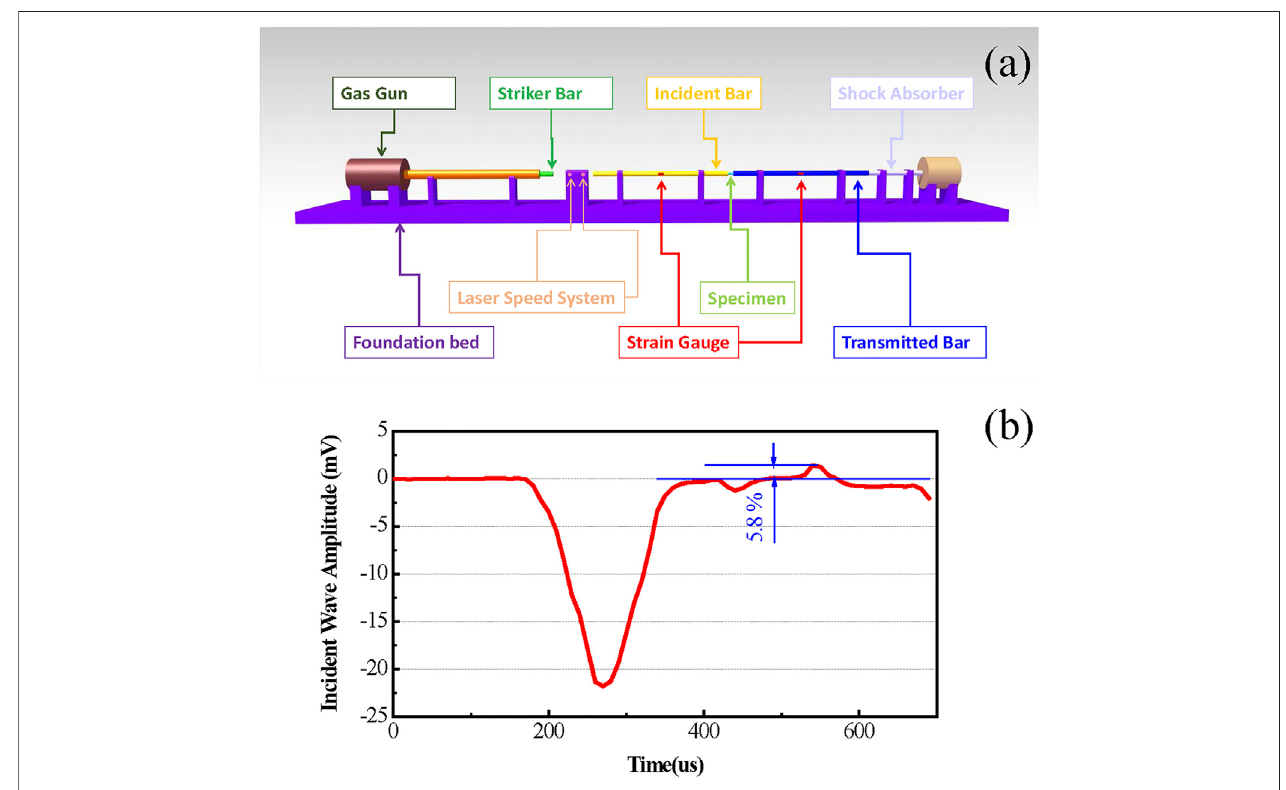
FIGURE1|(A) Schematicdiagram oftheSHPB devicefordynamic compression experience; (B) asuitable incidentwaveforloadingBMGssamplestoguarantee the reliability of data.